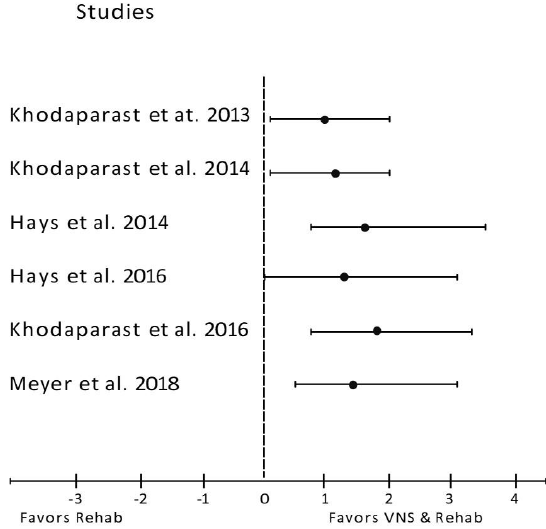
Figure 5. Forest plot: the outcome of vagus nerve stimulation (VNS) on forelimb strength. The effect of each study (“favors Rehab” , “favors VNS & Rehab” , or “no effect”) was estimated through the standardized mean difference (horizontal axis). The dashed vertical line at 0 indicates that the study was determined to have “no effect” . The horizontal bars in each chart plot represent the mean difference with a 95% confidence interval for each study [43–48].